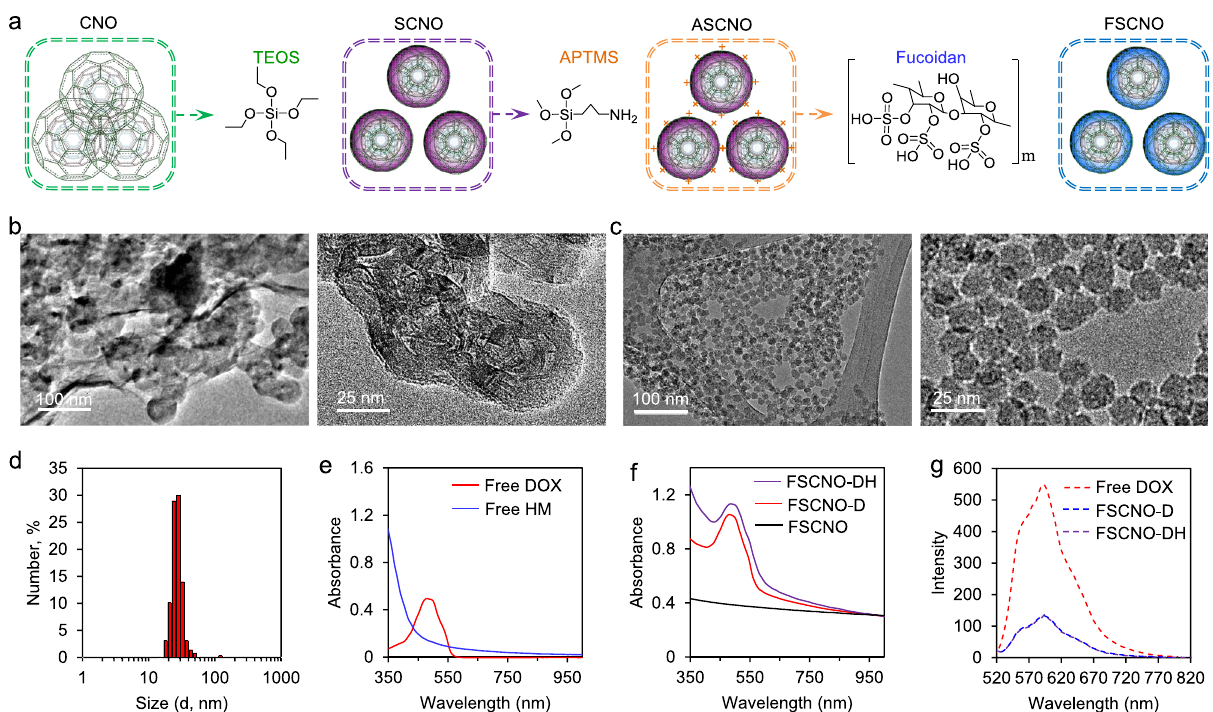
Fig. 2 Synthesis and characterization of nanoparticles. a A schematic illustration of the procedure for preparing the silica-carbon nano-onion (SCNO) nanoparticles using carbon nano-onions (CNOs) and tetraethyl orthosilicate (TEOS), modifying the SCNO nanoparticles with (3-Aminopropyl) trimethoxysilane (APTMS) to form ASCNO nanoparticles, and coating the ASCNO nanoparticles with fucoidan to produce the FSCNO nanoparticles. b, c Transmission electron microscopy (TEM) images of the CNOs ( b ) and FSCNO nanoparticles ( c ). d Size (in diameter) distribution of the FSCNO nanoparticles determined by dynamic light scattering (DLS) at room temperature. e UV-Vis absorbance of free doxorubicin hydrochloride (DOX) in deionized water and HM30181A (HM) in DMSO solution showing DOX has an absorbance peak at 485 nm while HM has strong absorption around 350 nm. f UV-Vis absorbance of FSCNO-D nanoparticles in deionized water showing an absorbance peak of DOX and FSCNO-DH in deionized water nanoparticles showing high absorbance at ~350 nm, suggesting the successful encapsulation of DOX and HM. g Fluorescence spectrophotometry of FSCNO-D and FSCNO-DH nanoparticles together with free DOX showing successful encapsulation of DOX in the two nanoparticles with a fl uorescence peak at ~590